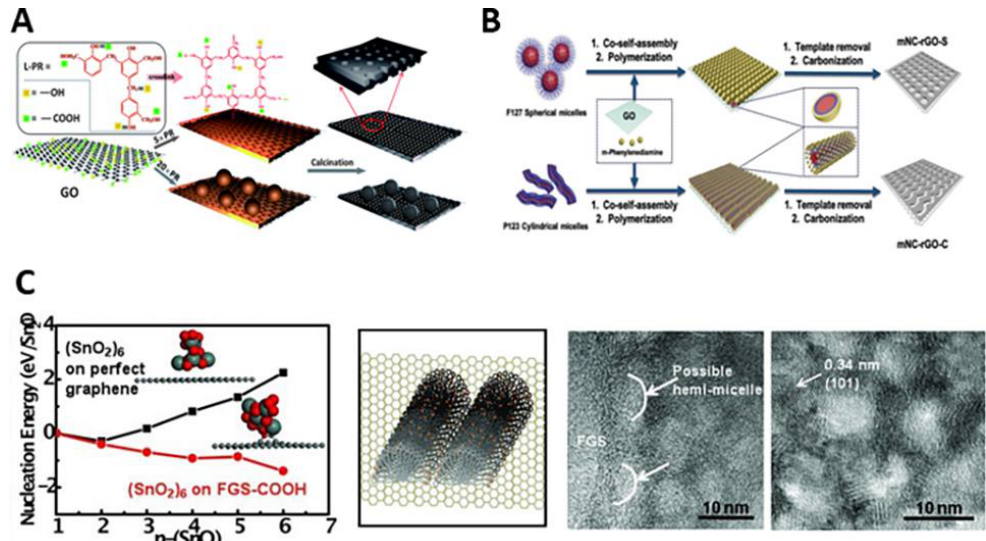
Figure 2. ( A ) Scheme of the preparation of mesoporous carbon/graphene (mC/G). Reprinted with permission from Ref. [62], Copyright (2013) The Royal Society of Chemistry. ( B ) Scheme of the fabrication of N-doped mC/G nanosheets with spherical or cylindrical pores through the interfacial self-assembly of Pluronic block copolymers in solution. Reprinted with permission from Ref. [63], Copyright (2019) John Wiley and Sons. ( C ) Density functional theory (DFT) calculation of SnO 2 nucleation on pristine G and on functionalized G sheets with a carboxylic group linking to the defect site, G template with the formation of ordered surfactant micelle structures, and transmission electron microscopy (TEM) images showing possible hemi-micelles at the interfaces and the crystalline mTiO 2 /G. Reprinted with permission from Ref. [69], Copyright (2012) John Wiley and Sons.